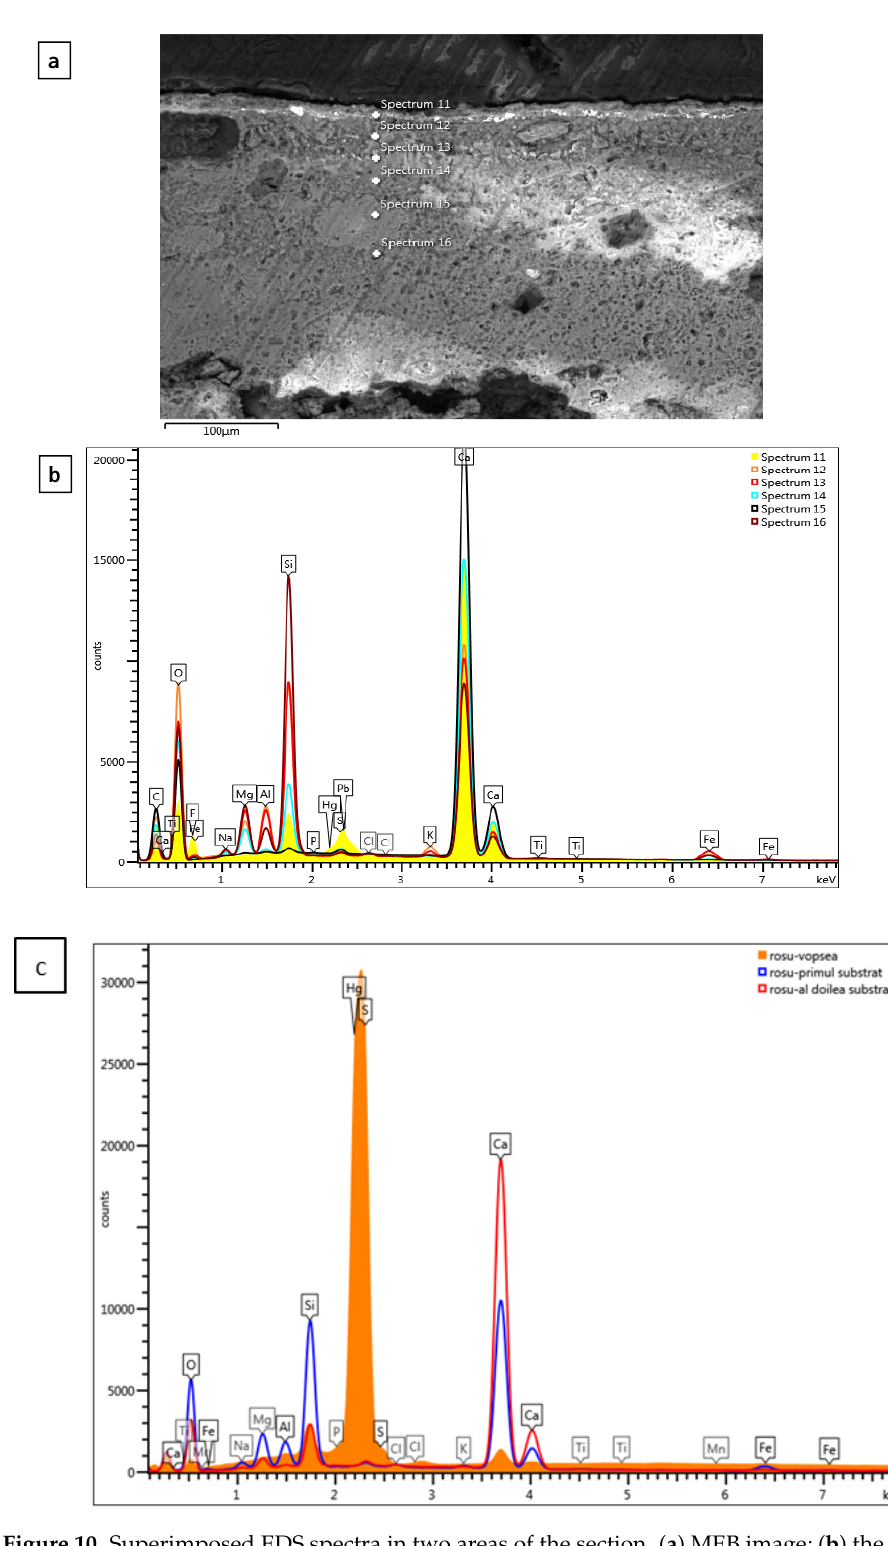
Figure 10. Superimposed EDS spectra in two areas of the section. ( a ) MEB image; ( b ) the evolution of the concentration of the elements on the thickness of the fresco fragment Figure 10a, 11-pictorial layer (with the presence of Fe-hematite, Hg, and S-cinnabar), 12-intonaco layer, 13-interface intonaco– arriccio, and 14-15-16-arriccio; ( c ) composition in three points (for another area in the fresco) orange for the pictorial layer (with the presence of Hg and S-cinnabar and Fe-hematite), blue for the intonaco layer, and red for the arriccio layer. For the mortar layers in both figures, the presence of specific chemical elements can be